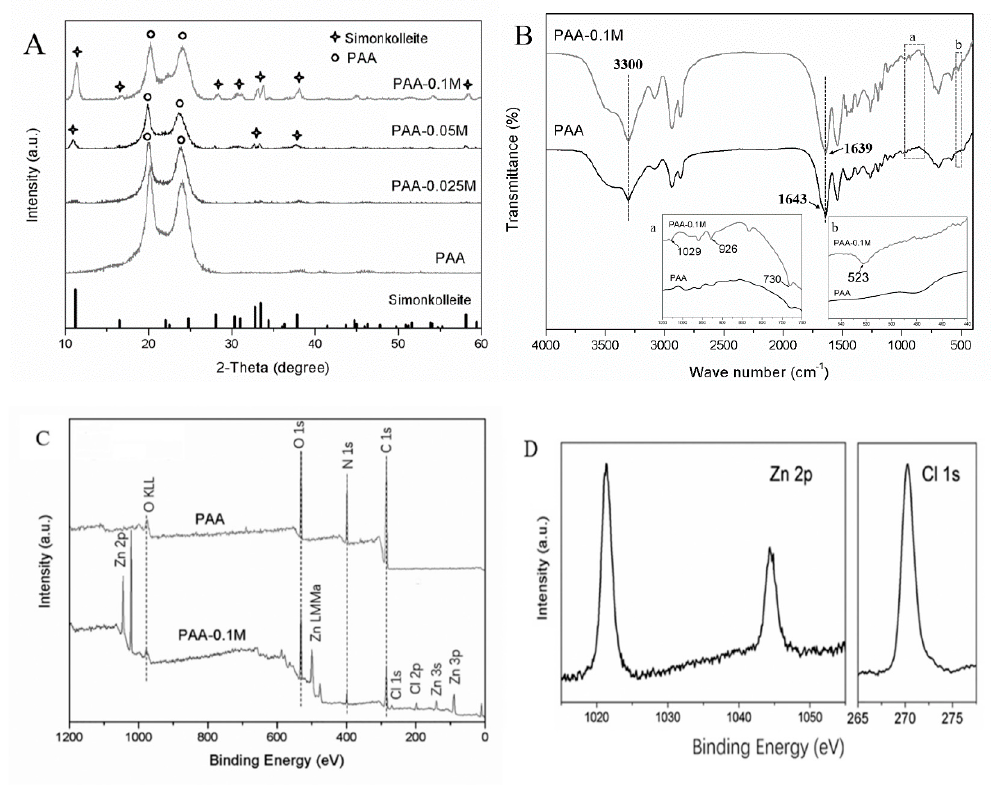
Figure 1. ( A ) The XRD patterns of PAA–0.1M, PAA–0.05M, PAA–0.025M and PAA (the simonkolleite spectrum was derived from the standard PDF card No. 00-07-0155); ( B ) The FT-IR patterns of PAA–0.1M and PAA: (a) the enlarged view from wavenumbers 1050 to 700 cm − 1 , (b) the enlarged view from wavenumbers 550 to 440 cm − 1 ; ( C ) The XPS spectrum of PAA–0.1M and PAA; and ( D ) the enlarged Zn 2p and Cl 1s regions of PAA–0.1M.